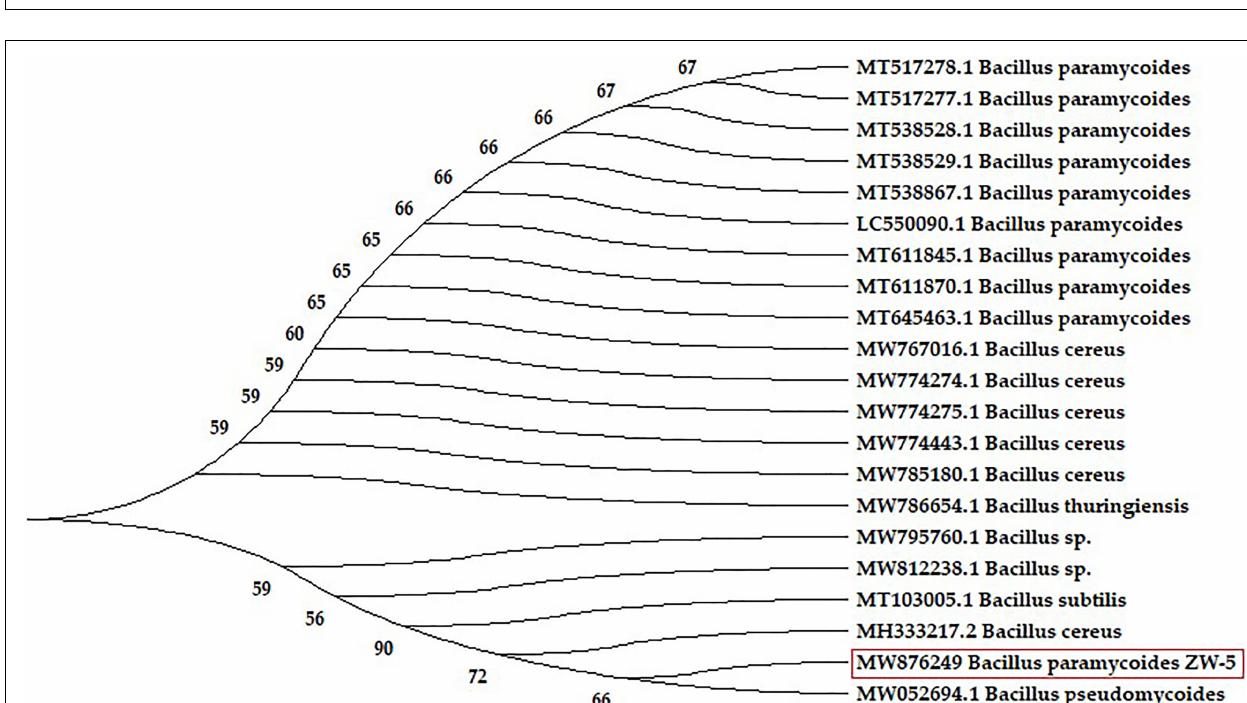
FIGURE 3 | Neighbor-joining phylogenetic tree based on 16S rRNA sequences, showing the relationships between strain ZW-5 (inside the red rectangle), and related species of Bacillus spp. GenBank accession numbers are presented in the front of strain names.